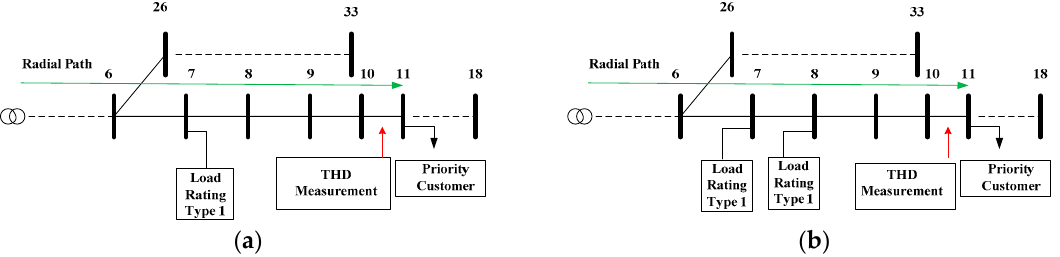
Figure 2. ( a ) Non-linear load connected at bus 7; ( b ) Non-linear load connected at bus 7 and bus 8. THD: Total Harmonic Distortion.